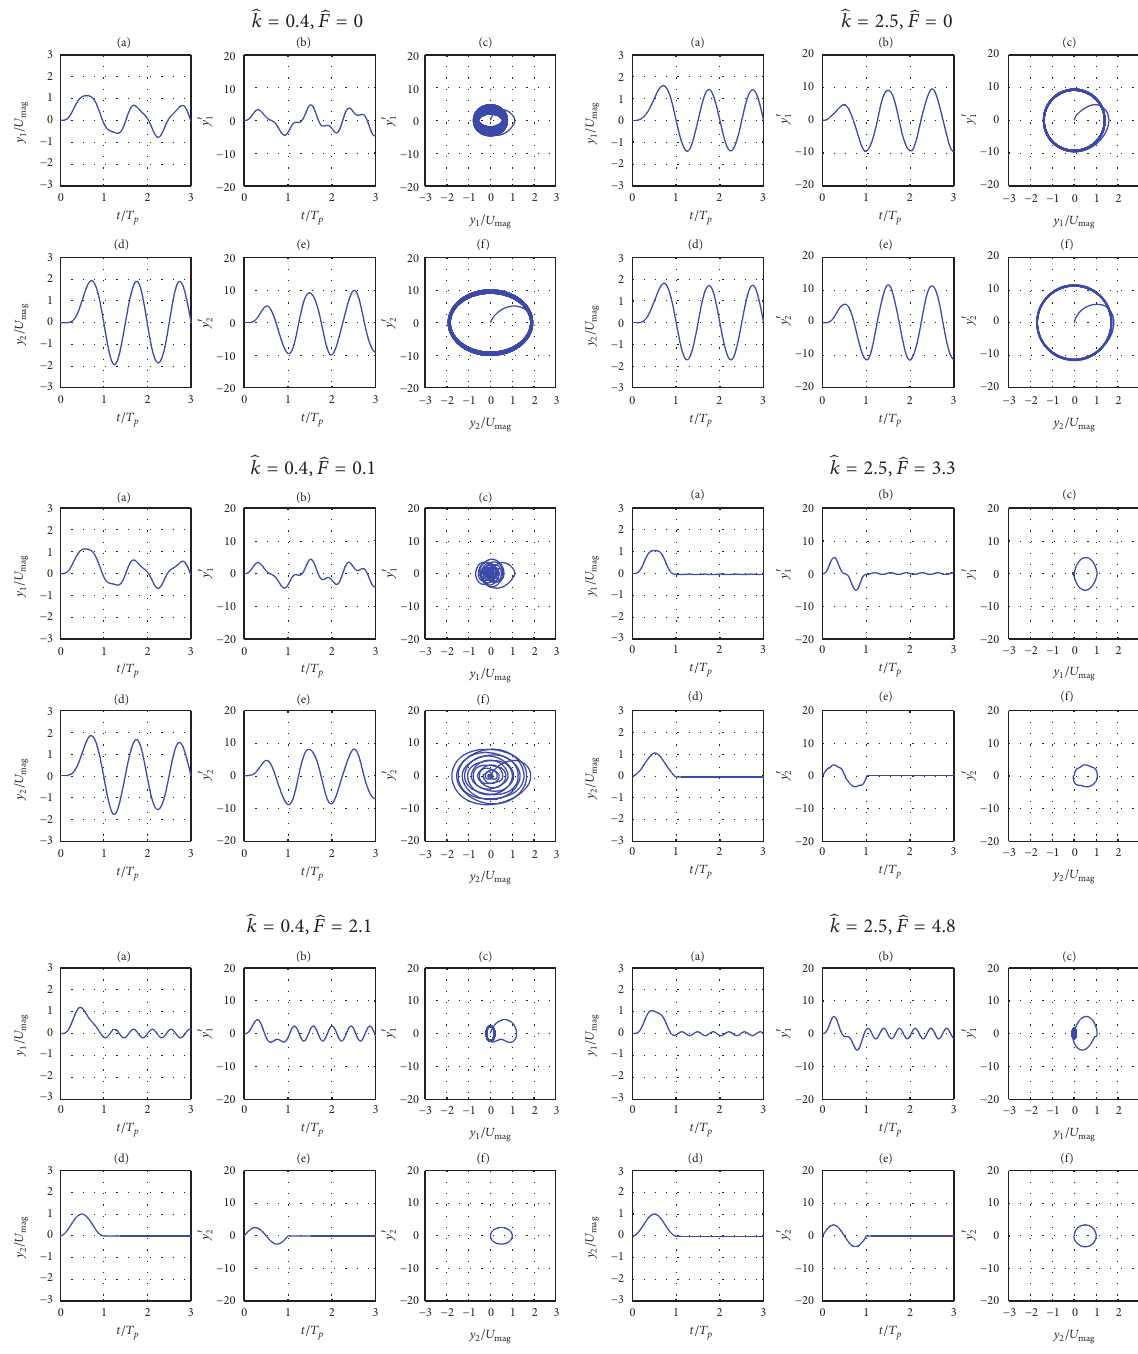
̂𝑘 = 0.4 ) and medium (frequency